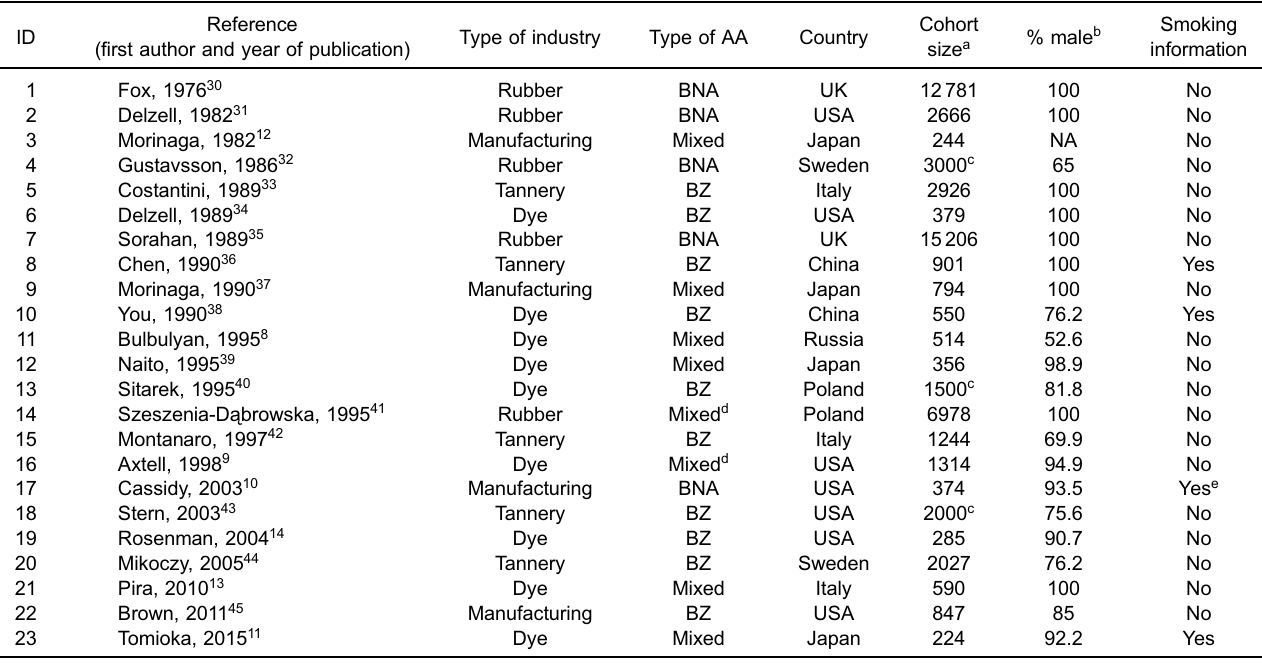
Table 1. Characteristics of 23 cohort studies included in a meta-analysis of lung cancer and exposure to benzidine (BZ) and/or beta-naphthylamine